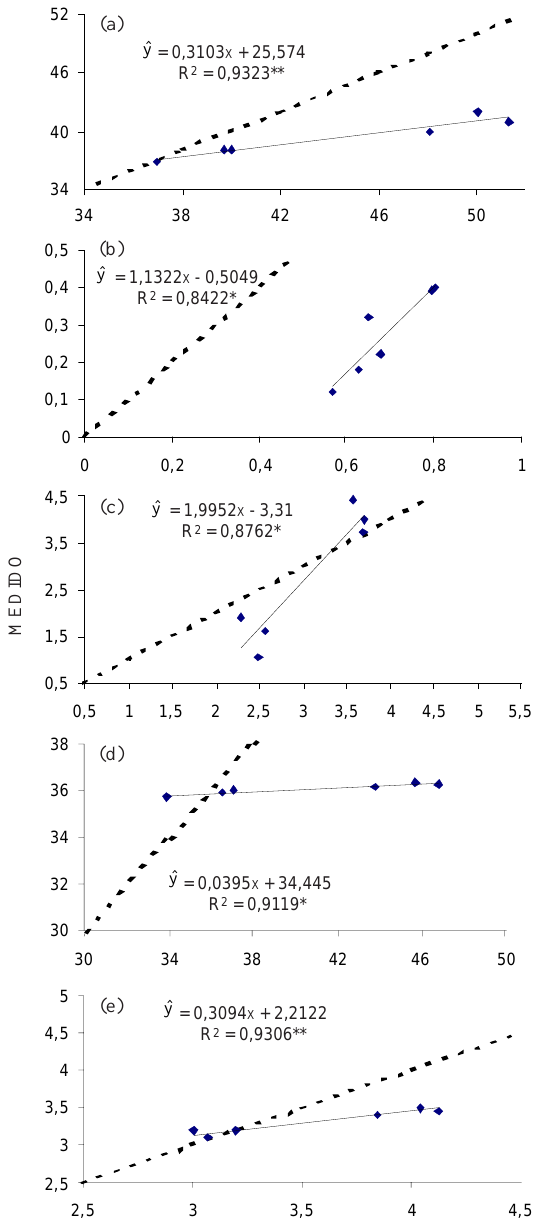
Figura 7. Relação entre estoques medidos e simulados de carbono orgânico total (a), de C nos compartimentos ativo (b), lento (c) e passivo (d) e de nitrogênio total (e). *, ** significativos a 0,05 e 0,01,